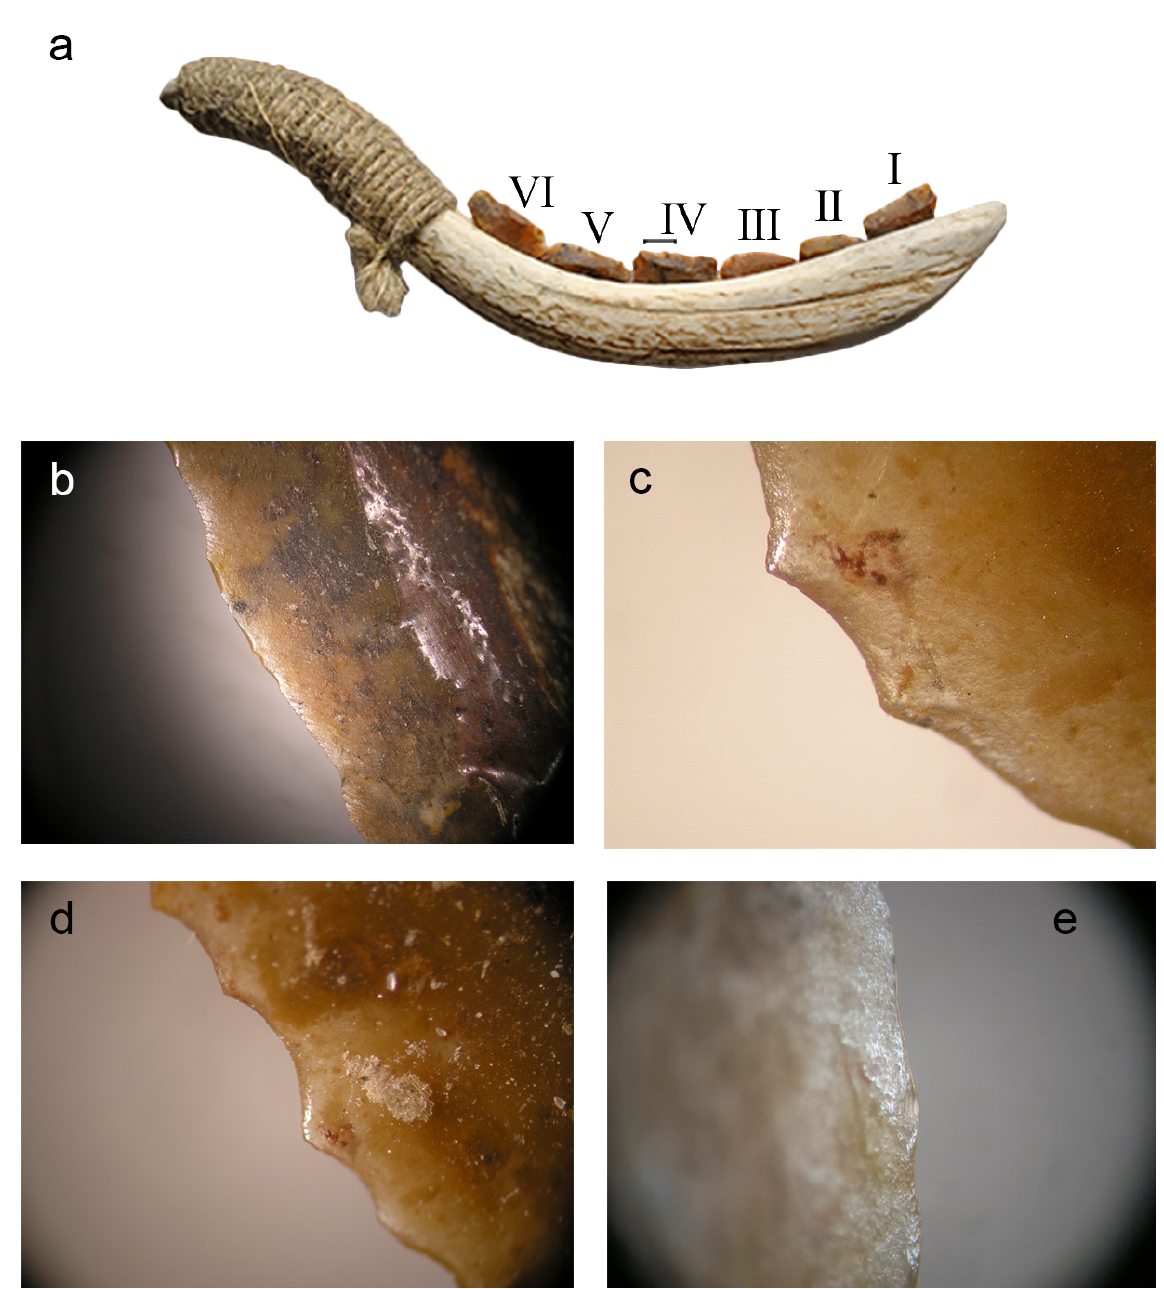
Figure 11. Vinča -Belo Brdo. a - replica 1; b - part of edge IV before harvest, c - after three hours of use (60x); d - after seven hours (30x); e - after nine hours